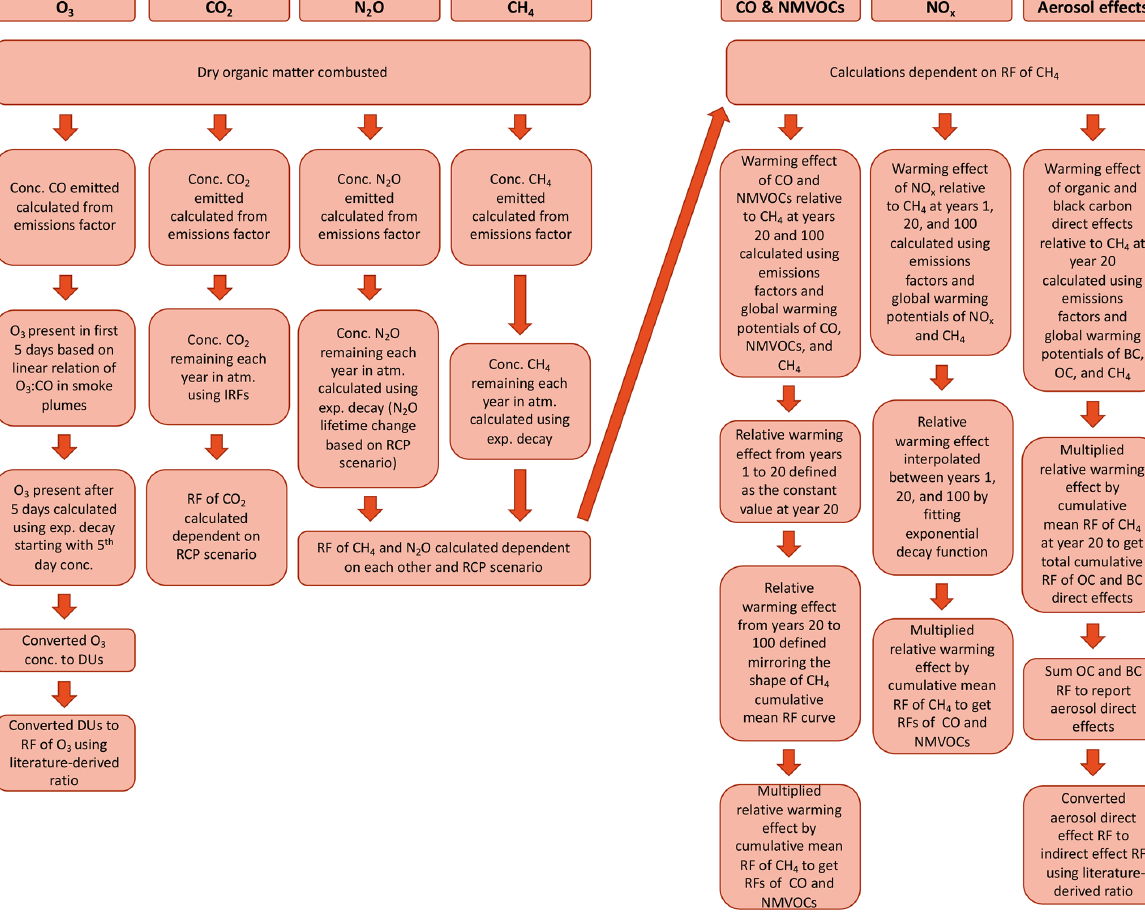
Figure A7. Flowchart of the methodology for the calculation of the radiative forcings of gaseous emissions from biomass combustion generally applicable to any biome with adjustment of biome-specific parameters.